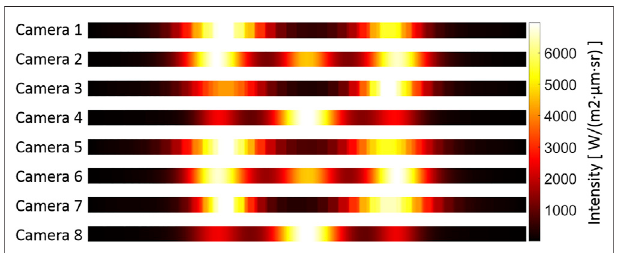
FIGURE 7 | The Schematic diagram of the layout of the 8 linear camera system.